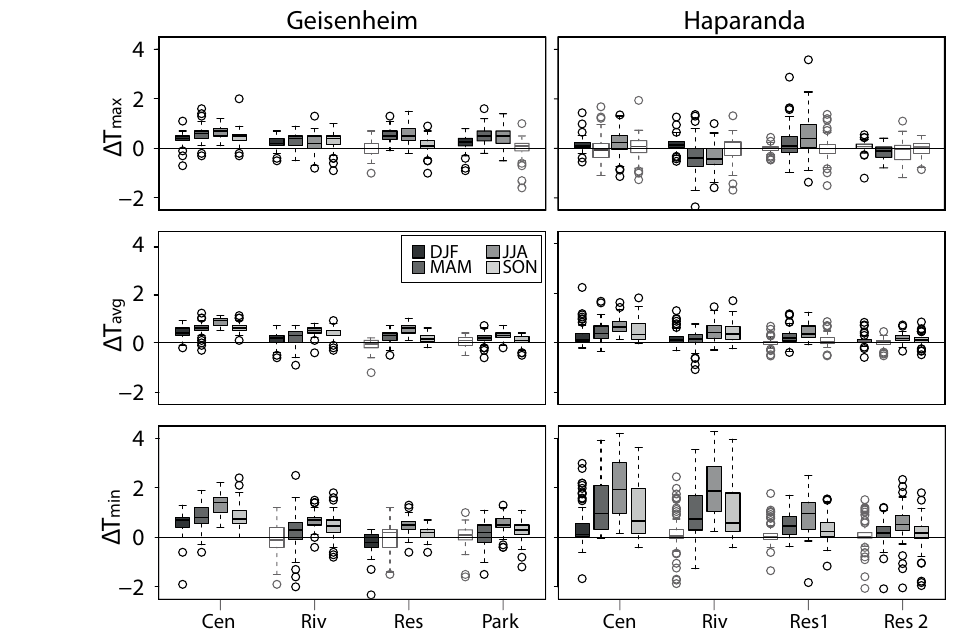
Figure 2. Boxplots of seasonal (cid:49)T max (top panels), (cid:49)T avg (middle panels) and (cid:49)T min (bottom panels), between the previous station locations/area typical environments and the current location of the met stations in Haparanda (left panels) and Geisenheim (right panels). Boxes show 25–75 percentile, with line across at median, whiskers extend to approximately 5–95 percentile and circles show outliers. Open, grey boxes are shown when sites do not differ significantly from the reference station or when difference is less than 0.1K (due to accuracy limitations of the loggers). Site names see Table